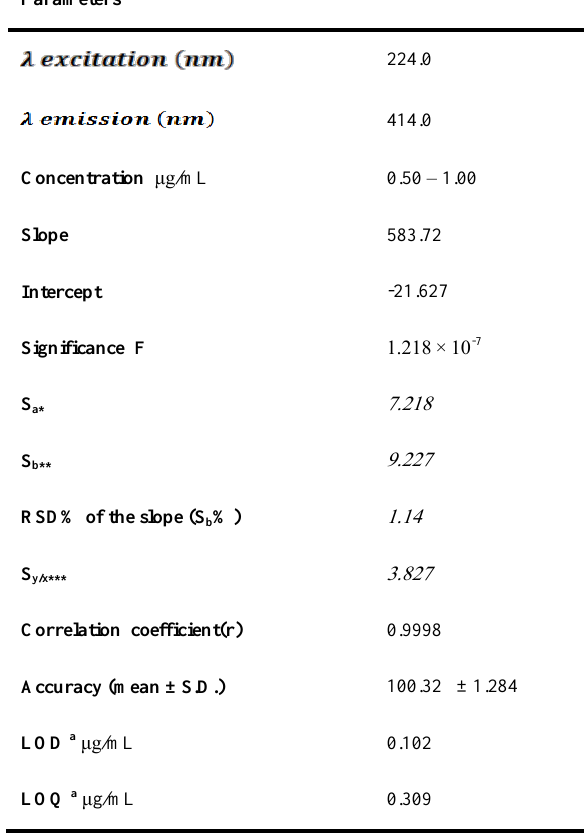
Table 1. Assay parameters and method validation for the determination of pure sample of BCT by the proposed spectrofluorometric